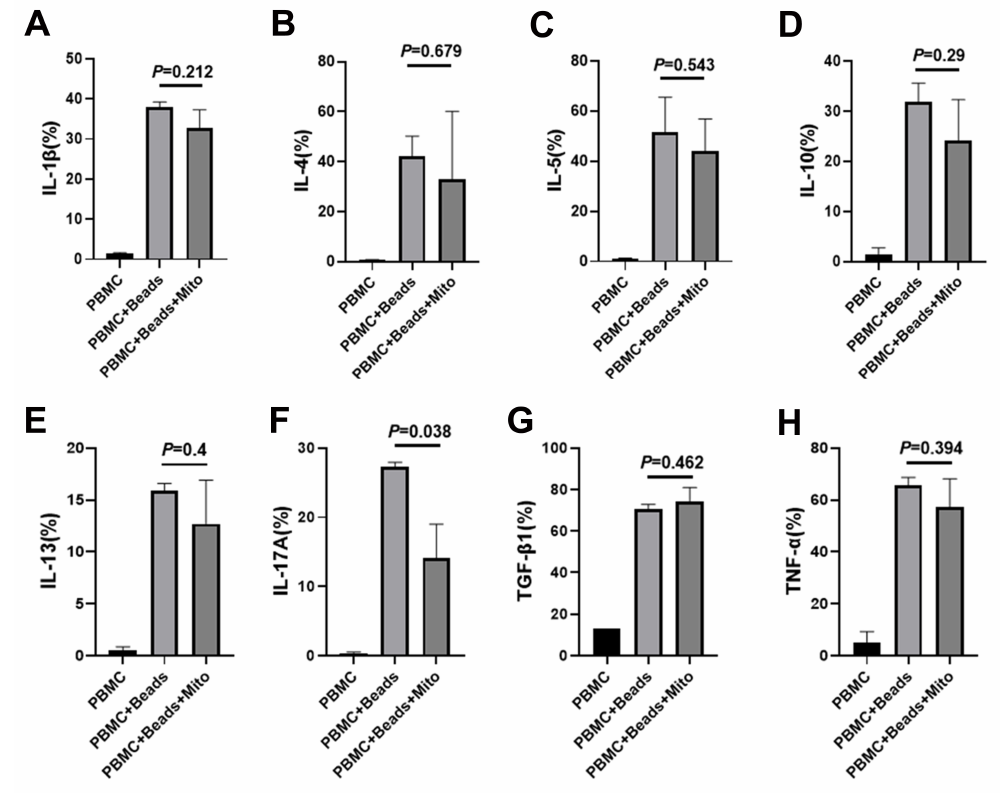
Figure 5. Intracellular cytokine analysis by flow cytometry. Health donor-derived PBMC ( N = 4) were treated with PB-derived mitochondria at 200 µ g / mL ( N = 4) in duplicate for 3 days in the presence of T-cell activator CD3 / CD28 Dynabeads. ( A – H ) There were no marked di ff erences in the percentages of IL-1 β ( A ), IL-4 ( B ), IL-5 ( C ), IL-10 ( D ), IL-13 ( E ), TGF- β 1 ( G ), and TNF- α ( H )-producing cells after the treatment with PB-derived mitochondria. ( F ) Downregulation of the percentage of IL-17A-positive cells after the treatment with PB-derived mitochondria. Data were given as mean ± SD (standard deviation, N =